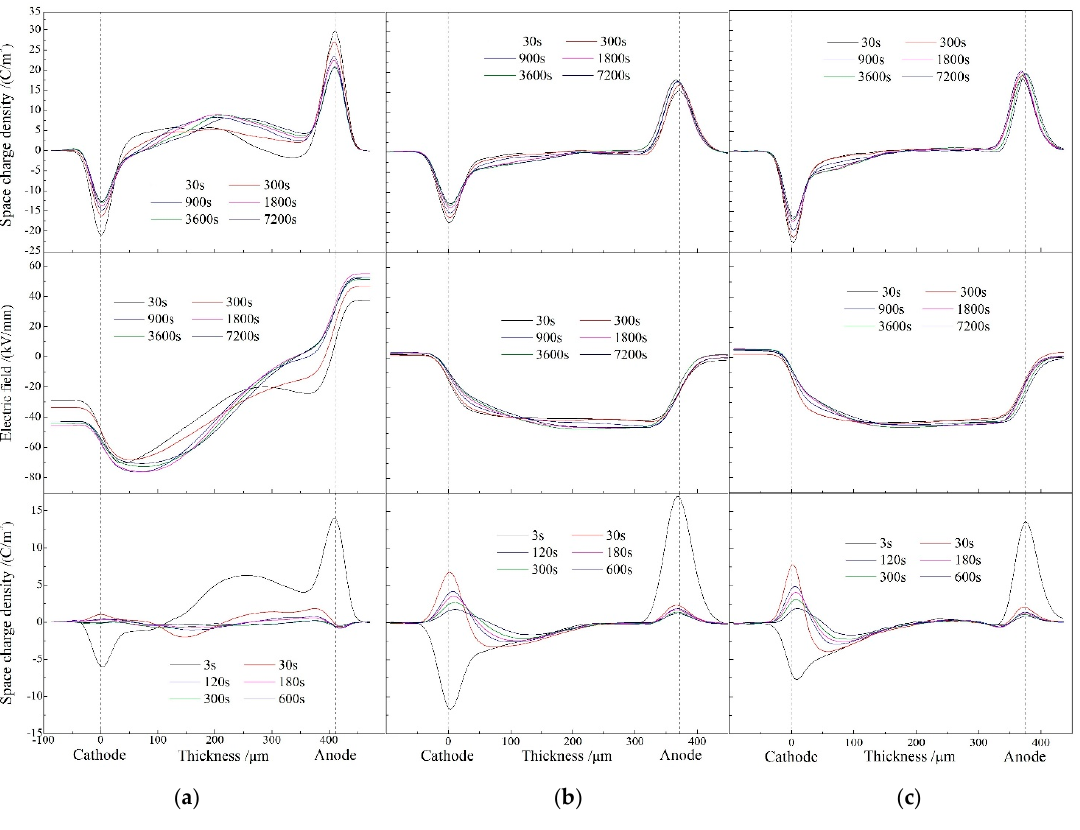
Figure 4. Space charge distributions at 80 °C in ( a ) XLPE, ( b ) XLPE-g-0.33wt%MAH, and ( c ) XLPE-g-0.41wt%MAH under applied DC electric field 40 kV/mm (upper panels) and in short-circuit (bottom panels). Electric field distributions across samples in polarization process are illustrated in middle panels.